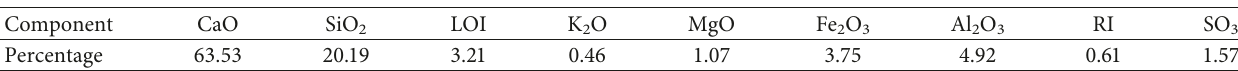
Table 3: Chemical composition of cement.